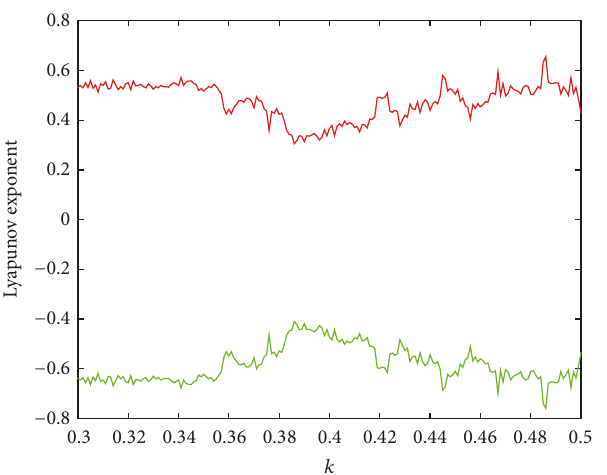
Figure 9: The bifurcation of the output with the change of anticon- trol parameter 𝑘